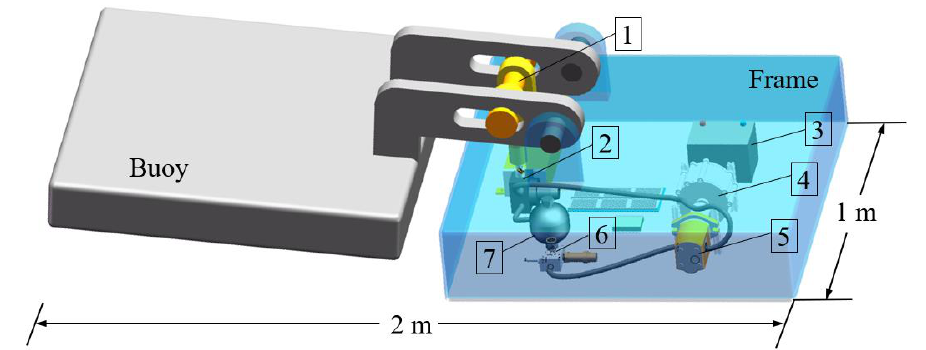
Figure 1. An overview of the proposed wave energy converter (WEC) with an electrohydraulic power take-off (PTO) system. 1: Piston rod; 2: Hydraulic piston pump; 3: Electric circuit (battery, control, etc.); 4: Electric generator; 5: Hydraulic motor; 6: Digital on-off valve; and 7: Hydraulic accumulator.